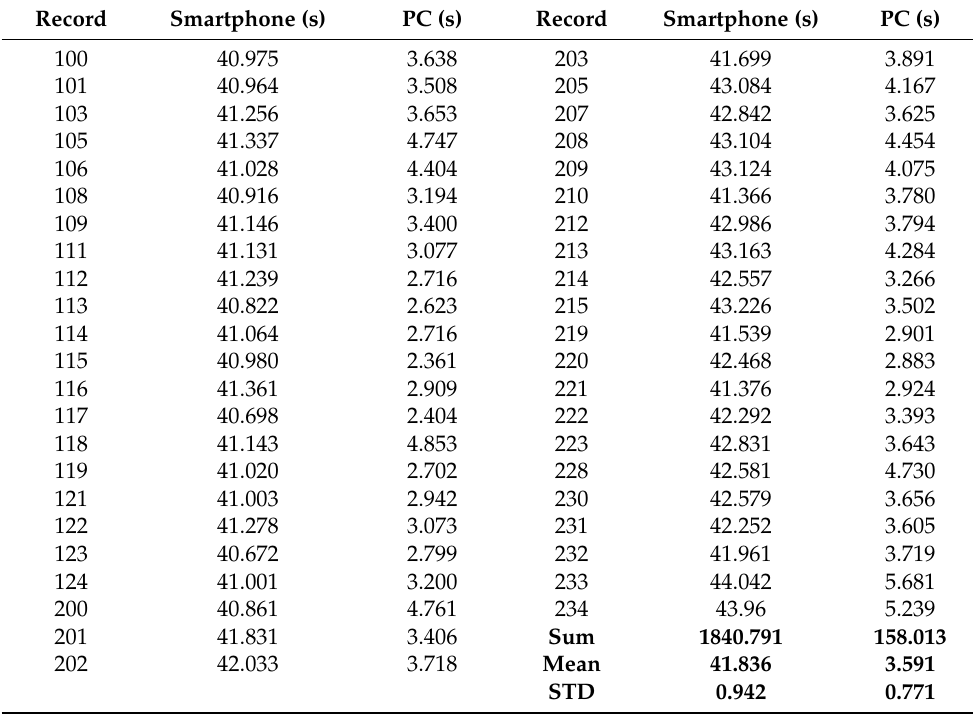
Table 7. The study evaluation time comparison in personal computer (PC) and smartphone for the MIT-BIH Arrhythmia database. (N/A = not